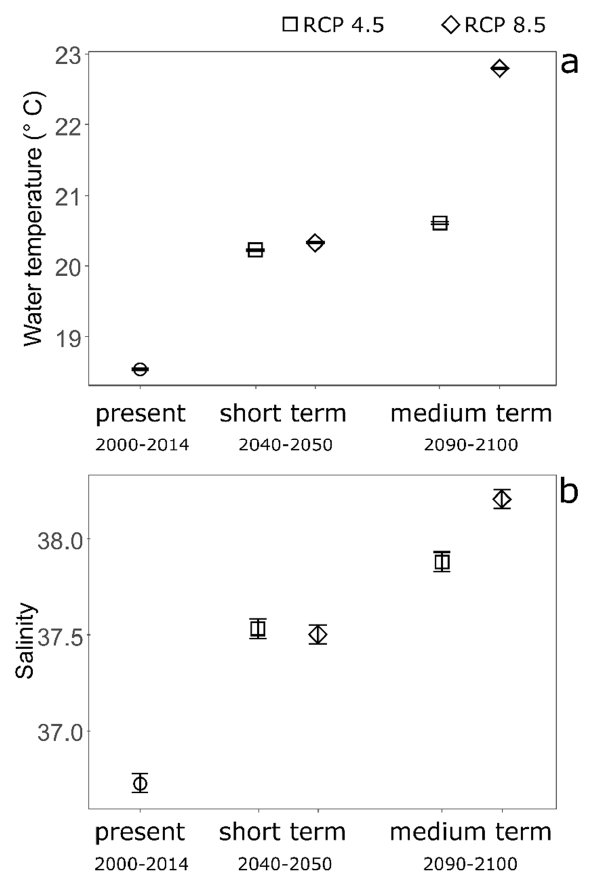
Figure 2. Mean ( ± st. err.) water temperature ( a ) and salinity ( b ) in the GSA17 at present (2000–2014, circle) and their expected values in the short (2040–2050) and medium (2090–2100) term according to the two IPCC scenarios RCP 4.5 (squares) and 8.5 (diamonds). Table 2. Mean R-index values calculated in the GSA17 for the 17 species considered by the present study. AUC (Area Under the Curve) metric was used to test for model performance according to the scale proposed by Hosmer and Lemeshow (1989): <0.5 = none; 0.5–0.7 = poor; 0.7–0.8 = acceptable; 0.8–0.9 = excellent; >0.9 = outstanding. Values in bold highlight when the difference between present and future habitat suitability was significant (Wilcoxon test, p < 0.001).